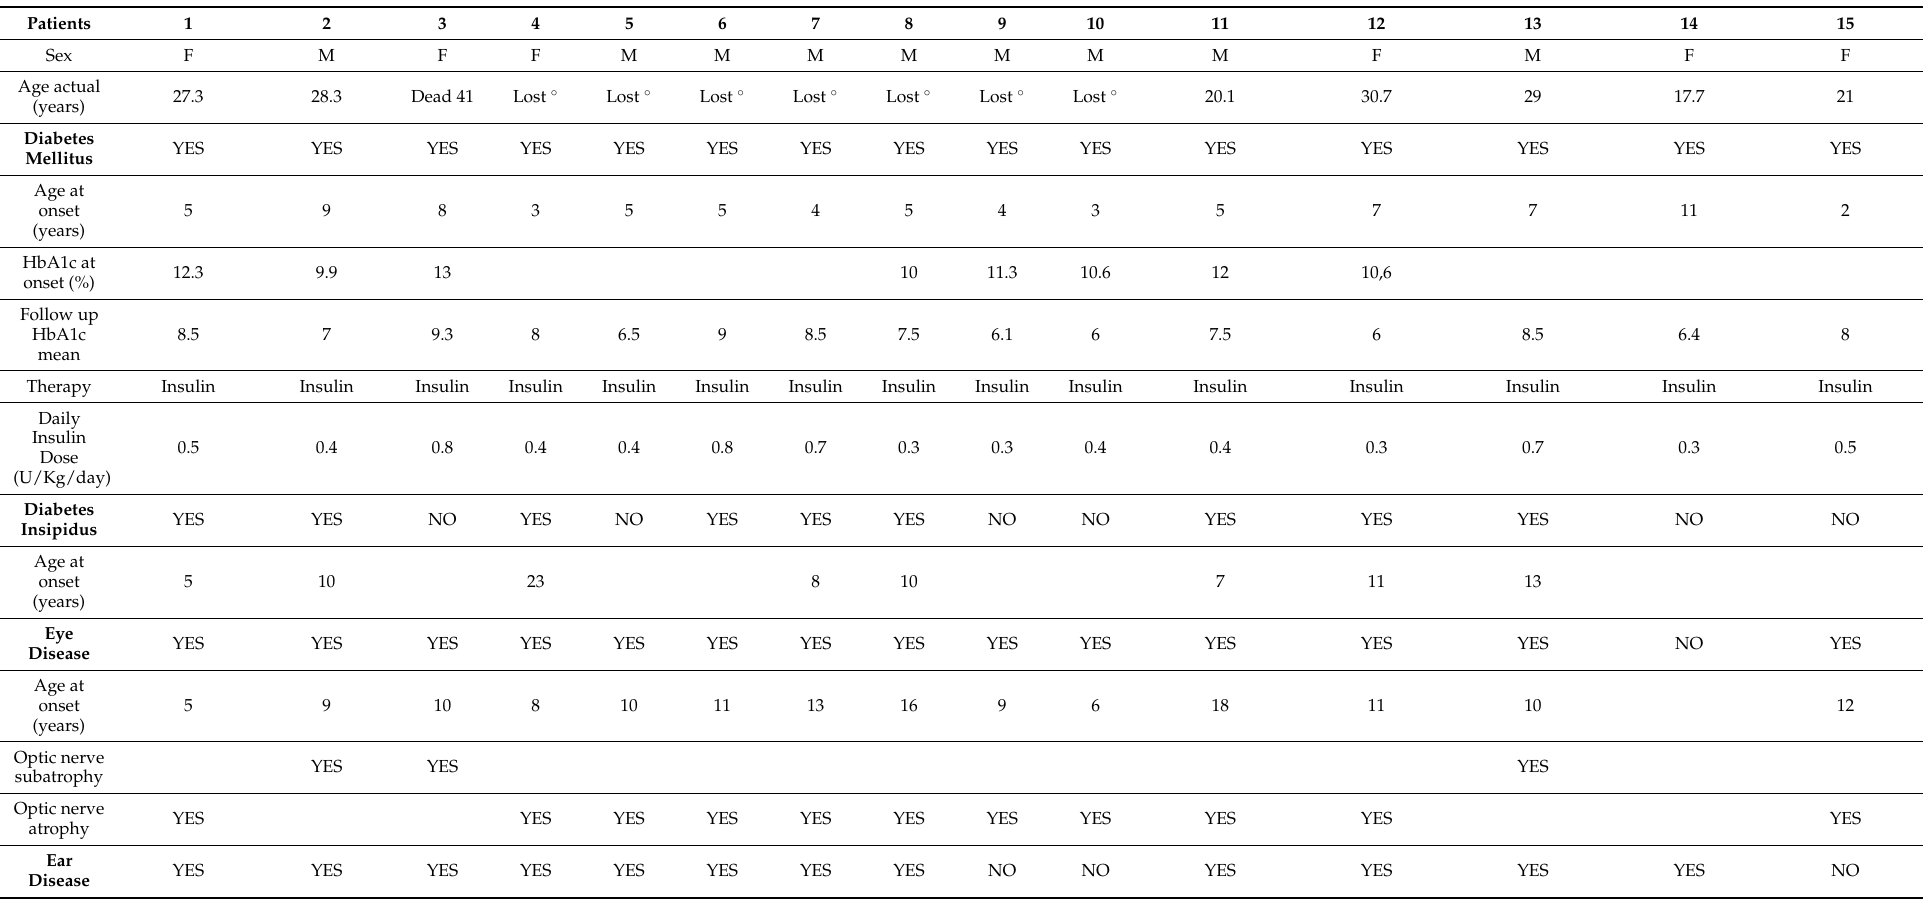
Table 1. Casuistic of Wolfram Syndrome patients of the Regional Center of Paediatric Diabetology “G. Stoppoloni” of University of Campania “Luigi